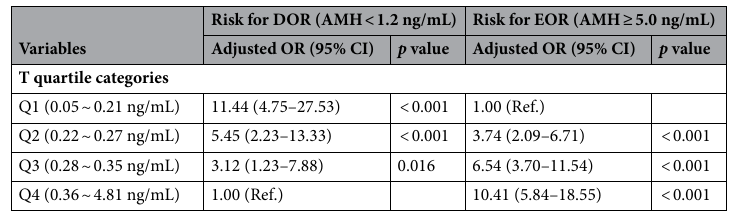
Risk for DOR (AMH < 1.2 ng/mL) Risk for EOR (AMH ≥ 5.0 ng/mL)